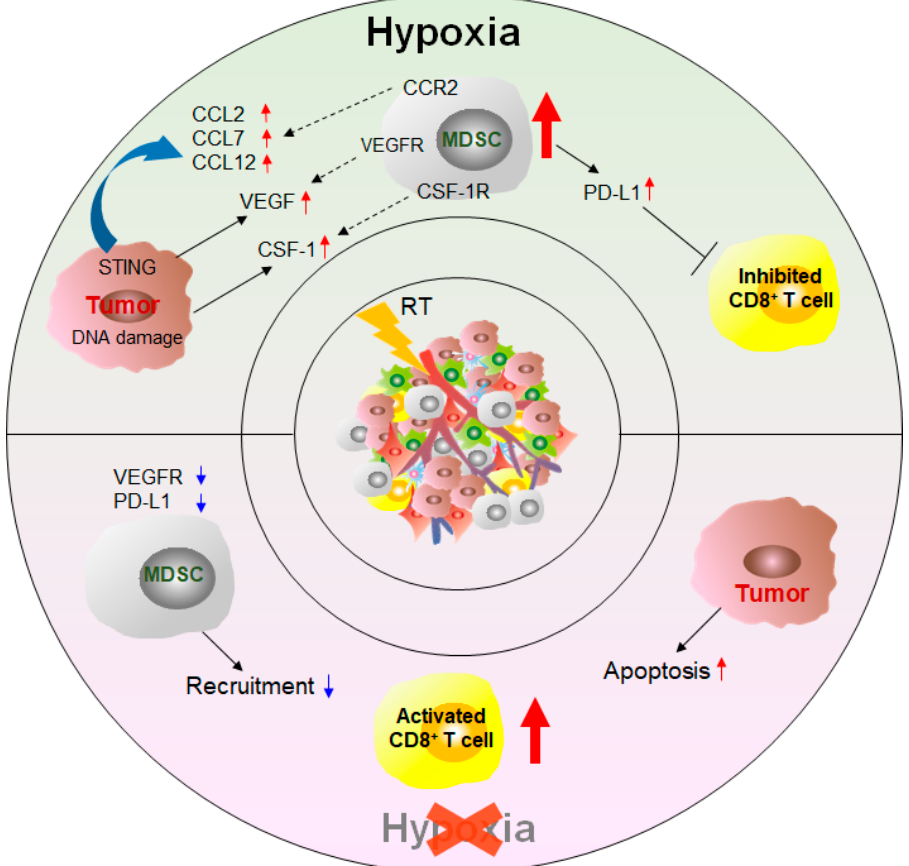
Figure 5. Effect of radiation therapy (RT) on MDSCs. Treatment with conventional fractionated radiotherapy (CFRT) promotes the secretion of tumor cytokines and chemokines in response to activation of the STING signaling pathway and DNA damage. These secreted factors bind to the receptors on the membrane of MDSCs, which increases the number of MDSCs migrating to the TME, upregulates the expression of PD-L1 on MDSCs, and strengthens the ability to suppress T cells. Ablative hypofractionated radiotherapy (ABHRT) reduces the recruitment of MDSCs by destroying the hypoxic environment in the TME and induces tumor apoptosis, leading to reactivation of the antitumor response. CCL, CC chemokine ligand; STING, stimulator of interferon genes; VEGF, vascular endothelial growth factor.